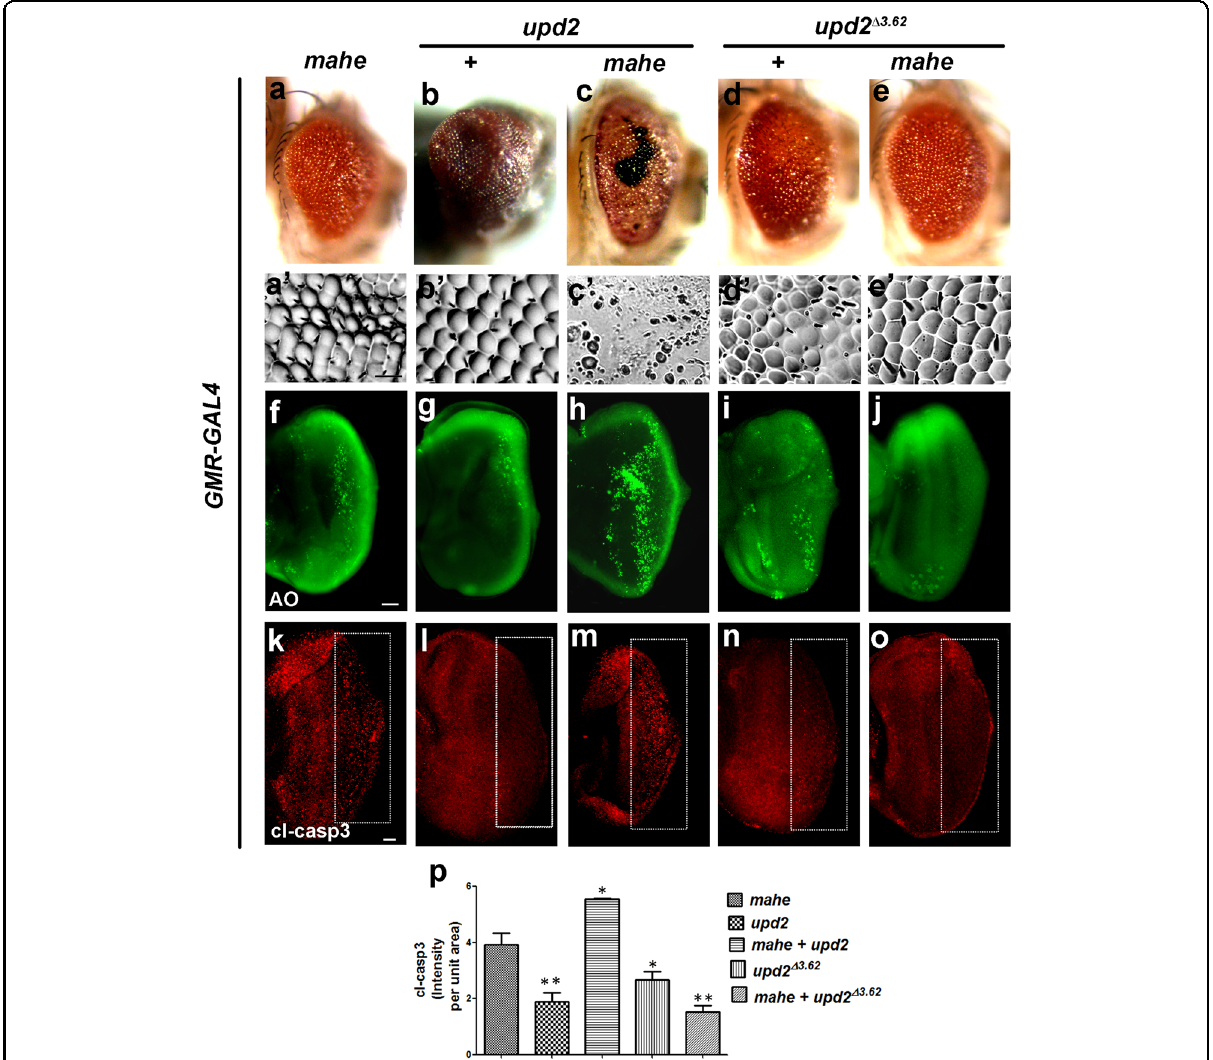
Drosophila adult eye. a ′ – e ′ Eye imprints of adult eye. GMR-GAL4 was used to drive the expression of UAS-mahe ( a , c , e ) or UAS-upd2 ( b , c ) . a , a ′ GMR- GAL4 > mahe promotes eye roughening. b, b ′ GMR-GAL4 driven upd2 resulted in severely overgrown eyes with regular patterned ommatidia. c , c ′ Coexpression of upd2 and mahe leads to pupal lethality whereas few escapers showed drastic eye roughness, with loss of pigmentation, black necrotic patches and loss of ommatidia in comparison to ectopic expression of mahe alone. d , d ′ upd2 Δ 3-62 a loss-of - function allele shows slightly disorganized and fused ommatidia along the dorsal side of adult eye. e , e ′ upd2 Δ 3-62 in combination with GMR-mahe suppressed the disorganized adult eye phenotype. f – j and k – o Acridine orange and caspase staining (compare area marked within rectangle) in eye-antennal disc of third instar larvae. f , k Acridine orange and caspase staining marked dying cells on ectopic expression of mahe . g , l Fewer acridine orange and caspase positive cells were observed upon upd2 overexpression. h , m Coexpression of upd2 and mahe enhanced cell death associated with mahe , which is re fl ected by increase in acridine orange and caspase positive cells when compared to mahe alone. i , n upd2 Δ 3-62 showed fewer acridine and caspase positive cells. j , o upd2 Δ 3-62 rescued the mahe induced cell death, which is depicted by reduced number of acridine orange and caspase positive cells. p Graph represents cl-caspase intensity per unit area which shows upd2 overexpression promotes mahe induced cell death, and was signi fi cantly reduced in combination with upd2 mutant. One - way ANOVA. Scale bar in 50 µm ( a ′ – e ′ , f – j , k – o ). Genotypes ( a ) w/ + ; + ; GMR-GAL4,UAS-HA-mahe/ + ( b ) w/ + ; UAS-upd2:GFP/ + ;GMR-GAL4/ + ( c ) w/ + ;UAS-upd2:GFP/ + ;GMR-GAL4,UAS-HA-mahe/ + ( d ) upd2 Δ 3.62 / + ; + ; + ( e ) upd2 Δ 3.62 / + ; + ; GMR-GAL4, UAS-HA-mahe . One-way ANOVA * P < 0.05, ** P < 0.01, *** P <